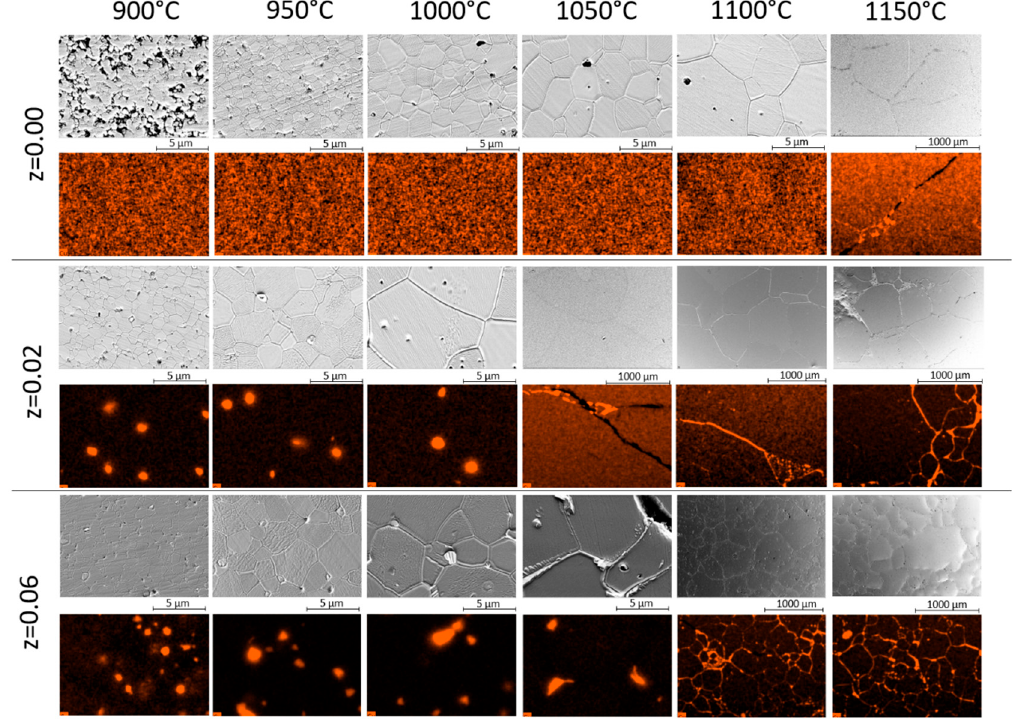
Figure 2. Microstructure images (SEM, SE mode) and EDX mapping of Cu-distribution in dependence of sintering temperature for z = 0.00, 0.02, and 0.06 (representative examples; SEM and EDX not from the same sample area) .